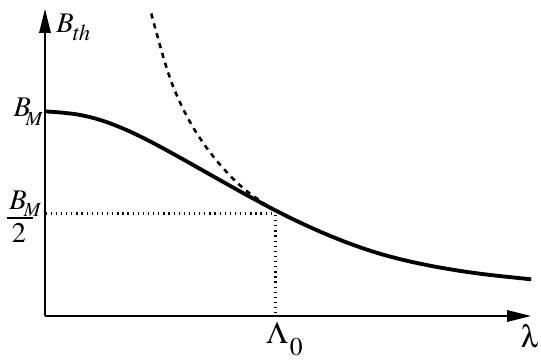
Figure 8. Tunneling suppression B th in flat spacetime at different temperatures λ/ (2 π ) . Dashed line represents the decay channel via the sphaleron. The change to sphaleron dominated transitions occurs at Λ given by eq. (3.9). B represents suppression in empty space, eq. 0 M